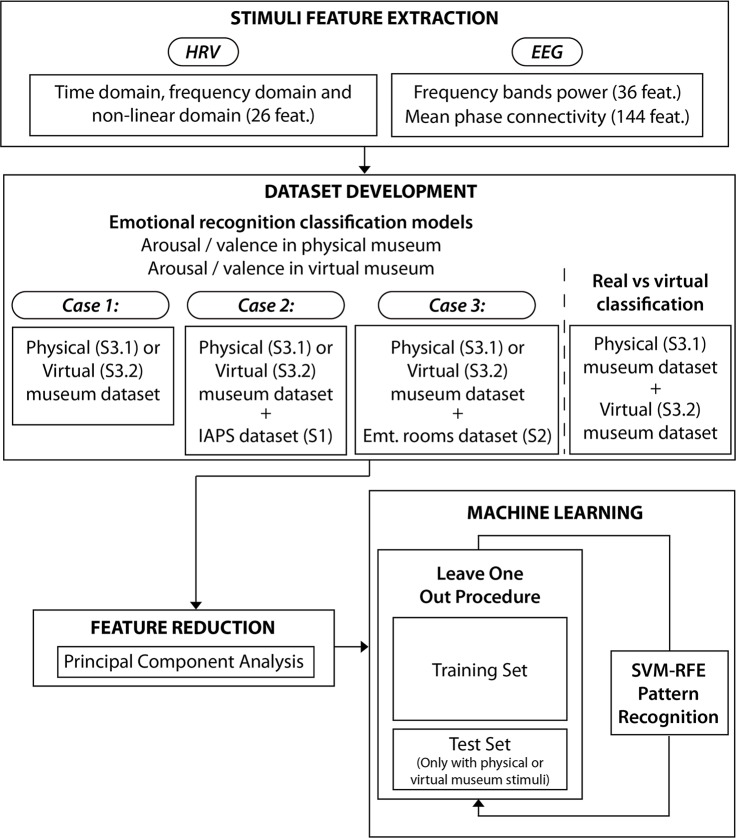
Overview of the data analysis and emotional pattern recognition.